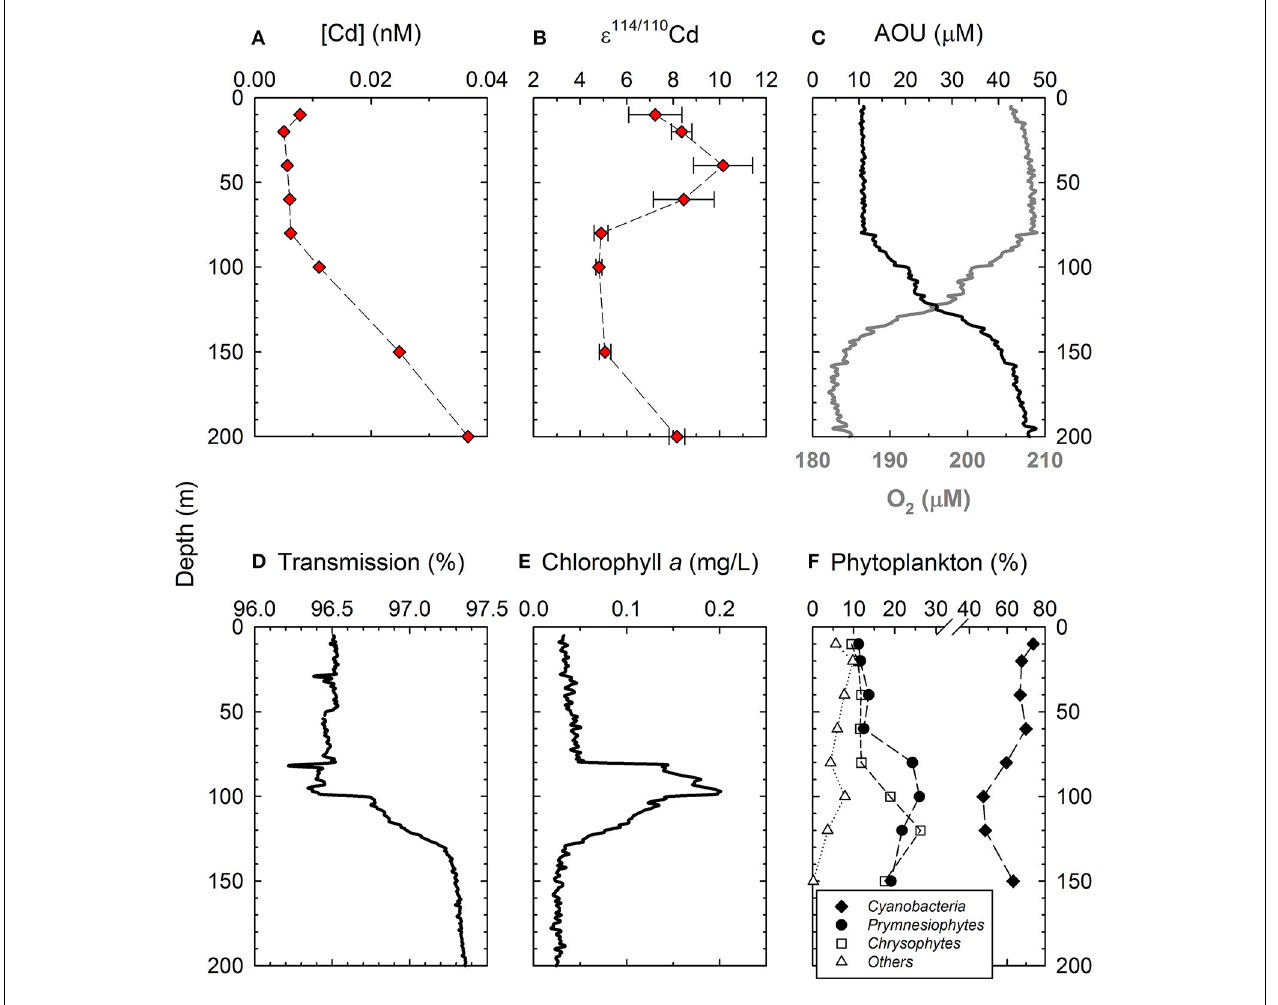
concentrations; (B) ε 114 / 110 Cd; (C) O 2 and AOU; (D) transmission; (E) Chlorophyll a concentrations; and (F) phytoplankton community structure. Data of phytoplankton community structure data are from Yang et al.